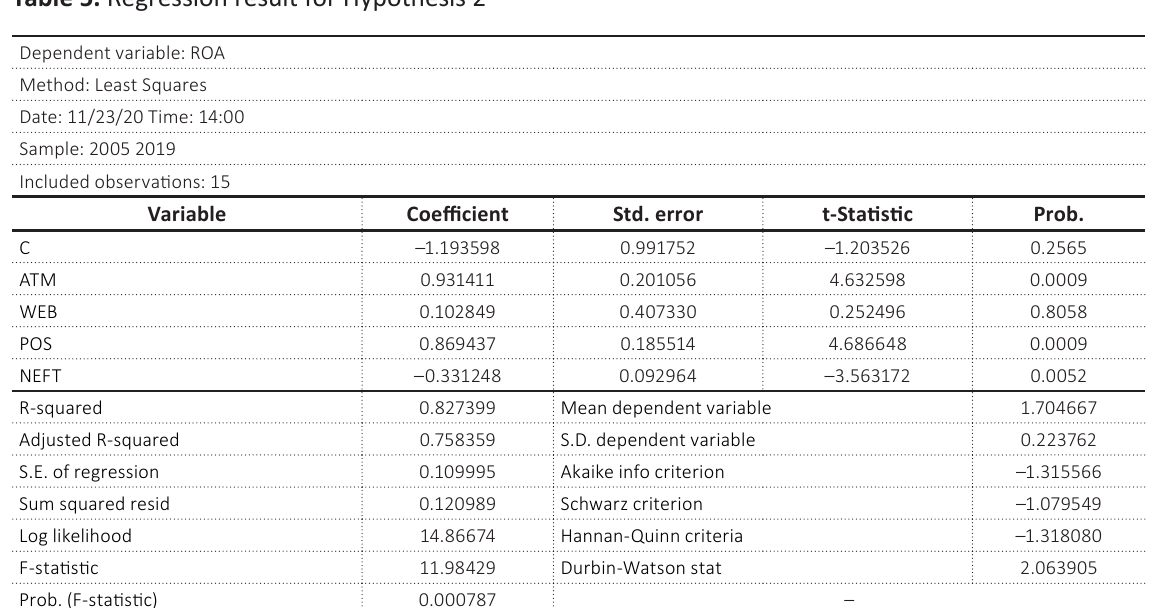
Table 5. Regression result for Hypothesis